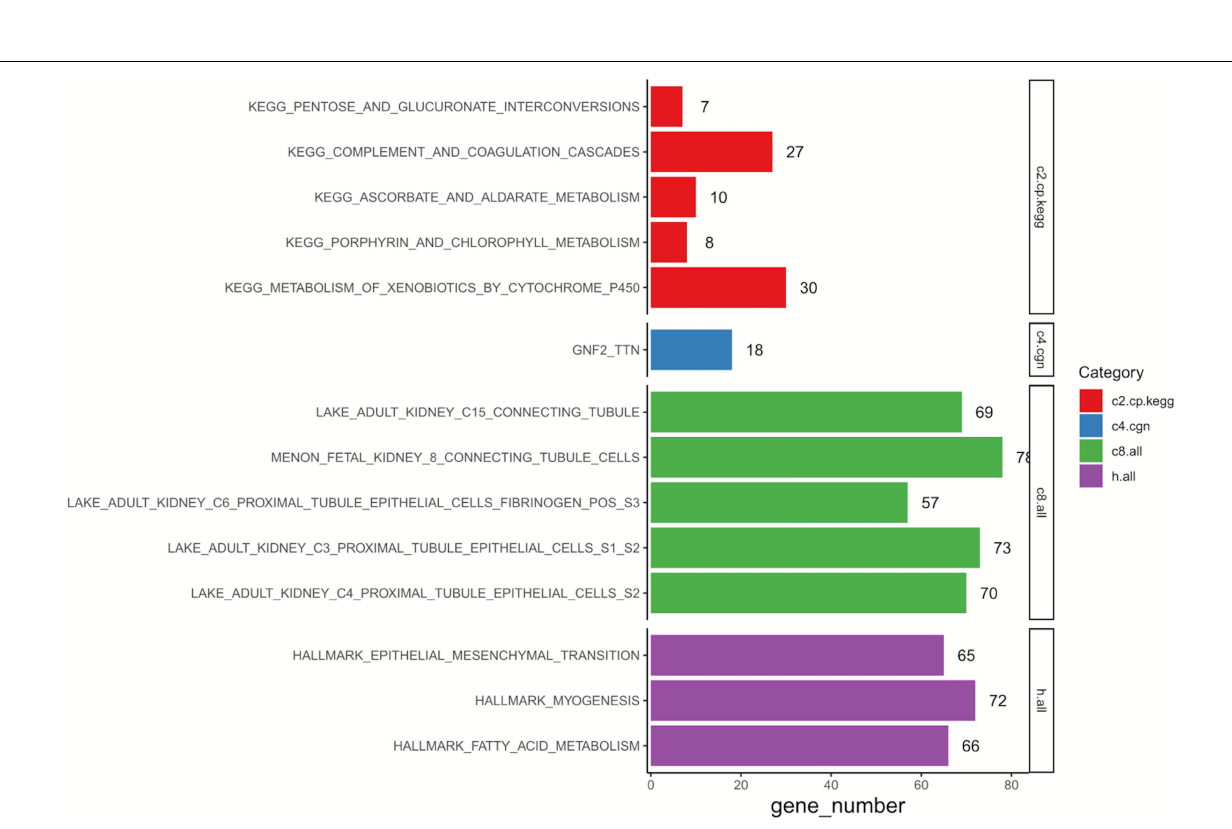
Frontiers in Genetics |